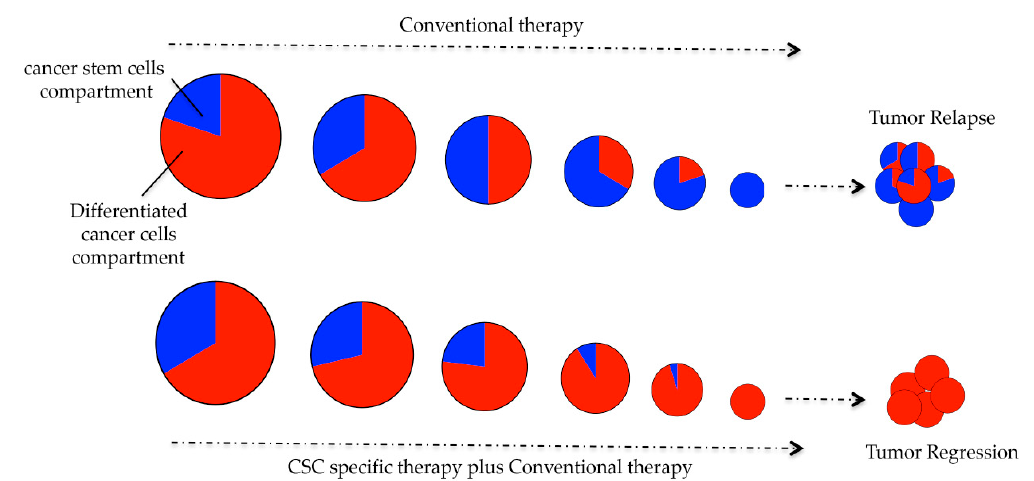
Figure 1. Cancer stem cells (CSCs) model of drug resistance:CSCs are responsible for tumor heterogeneity, drug resistance and tumor relapse. Indeed, they may survive chemotherapy lead to tumor relapse. Only by taking advantages of a CSCs specific targeted therapy, the outcome could result in tumor regression and patients’ complete